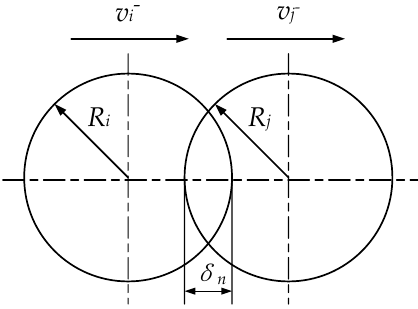
Figure 1. Particle normal collision contact model.